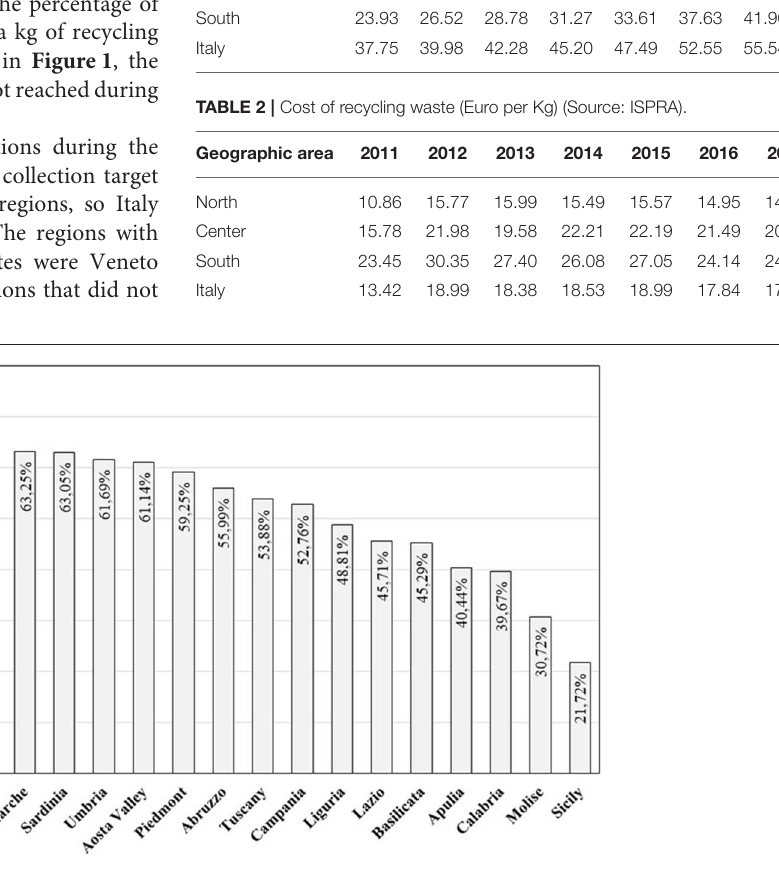
Frontiers in Sustainable Cities |